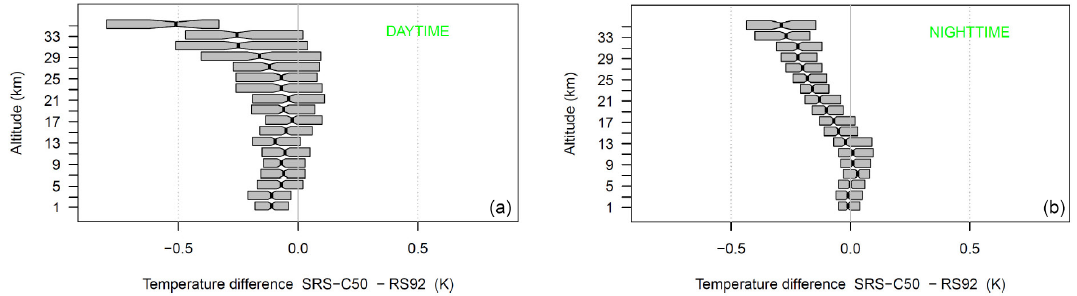
Figure 2. Temperature deviation of SRS-C50 with respect to RS92 calculated from the GRUAN multi-payload flights dataset during February–December 2018. The boxes are centred in the mean bias and span the 25th–75th percentile range. Statistics are based on 25 flights at 11:00UTC (a) and 26 flights at 23:00UTC (b)